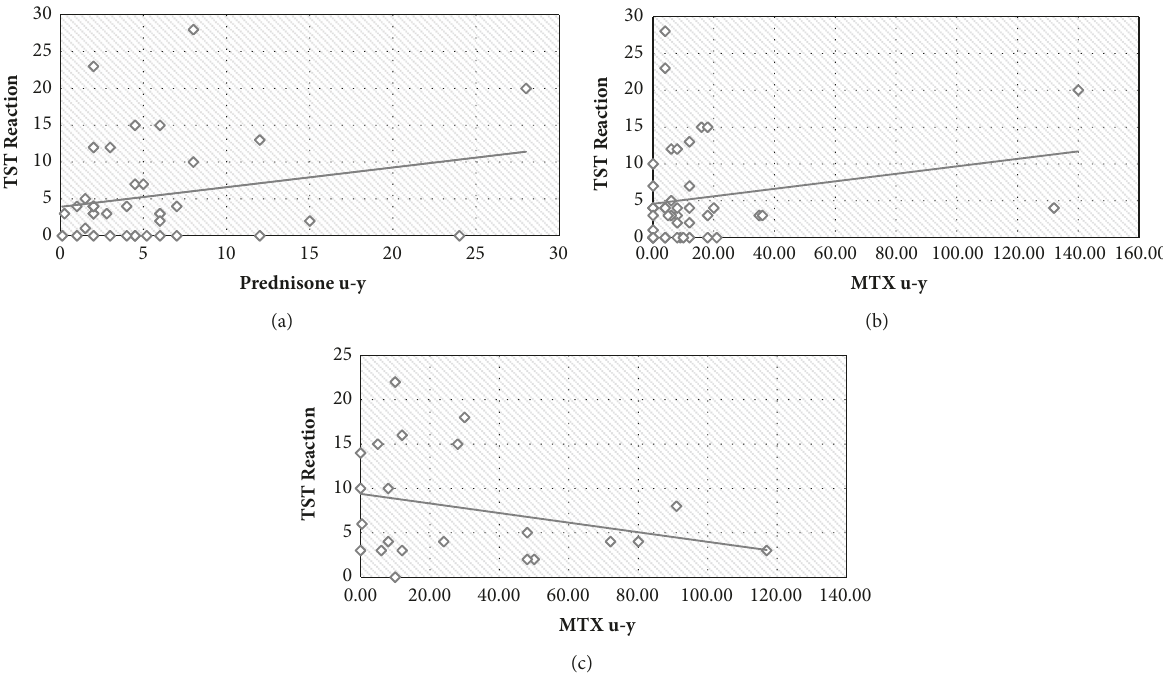
Figure 2: Correlation between TST size and (a) prednisone u-y in RA patients with prednisone therapy, (b) MTX u-y in RA patients with prednisonetherapy,and(c)MTXu-yinRApatientswithoutprednisonetherapy.TST=tuberculinskintest;u-y=unityears;RA=rheumatoid arthritis; MTX =